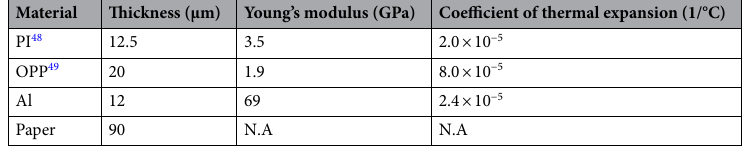
Table 1. Thermal and mechanical properties of the film material for bimorph actuator